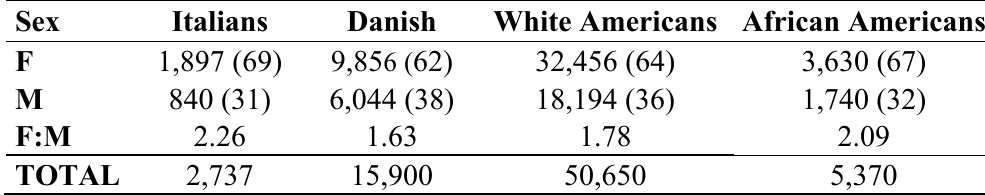
Table 1. Gender distribution of the MS study populations, n